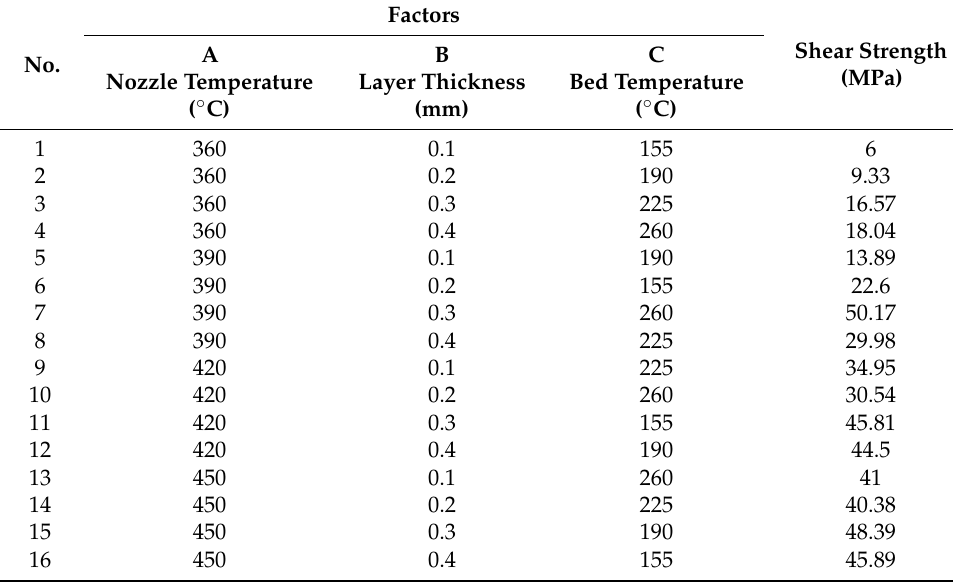
Table 3. Results of the orthogonal experiment.